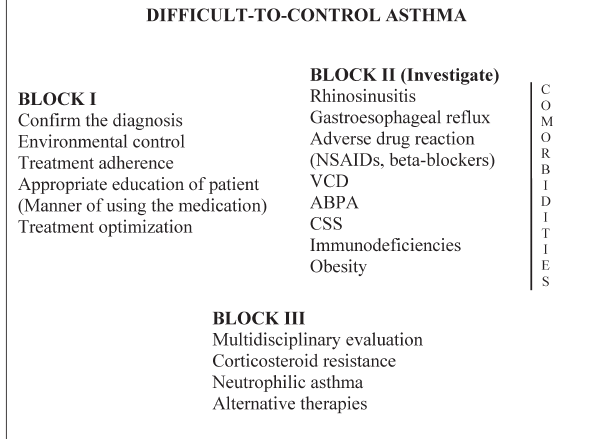
Figure 2 - Protocol for the treatment of patients with difficult-to- control asthma. VCD: vocal cord dysfunction; ABPA: allergic bronchopulmonary aspergillosis; NSAIDs: nonsteroidal anti-inflammatory drugs; CSS: Churg-Strauss